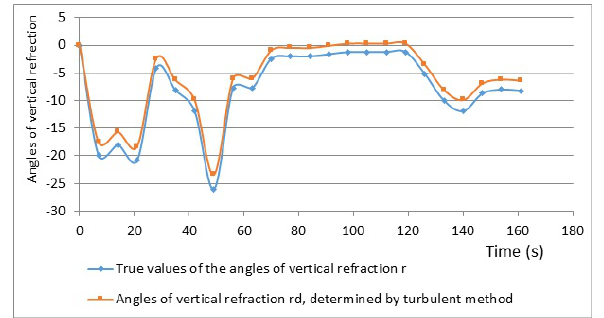
Fig. 2. The difference between angles of vertical refraction r mined by turbulent method and true values of the angles of vertical refraction r . The observations were carried out in sunny weather and weak wind at 11:00 am (local time), at air temperature 22 ... 24 ◦